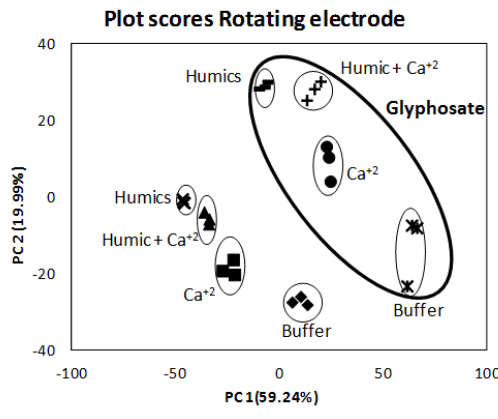
Figure 4. Principal component analysis score plot for the rotating electrodes on different aqueous